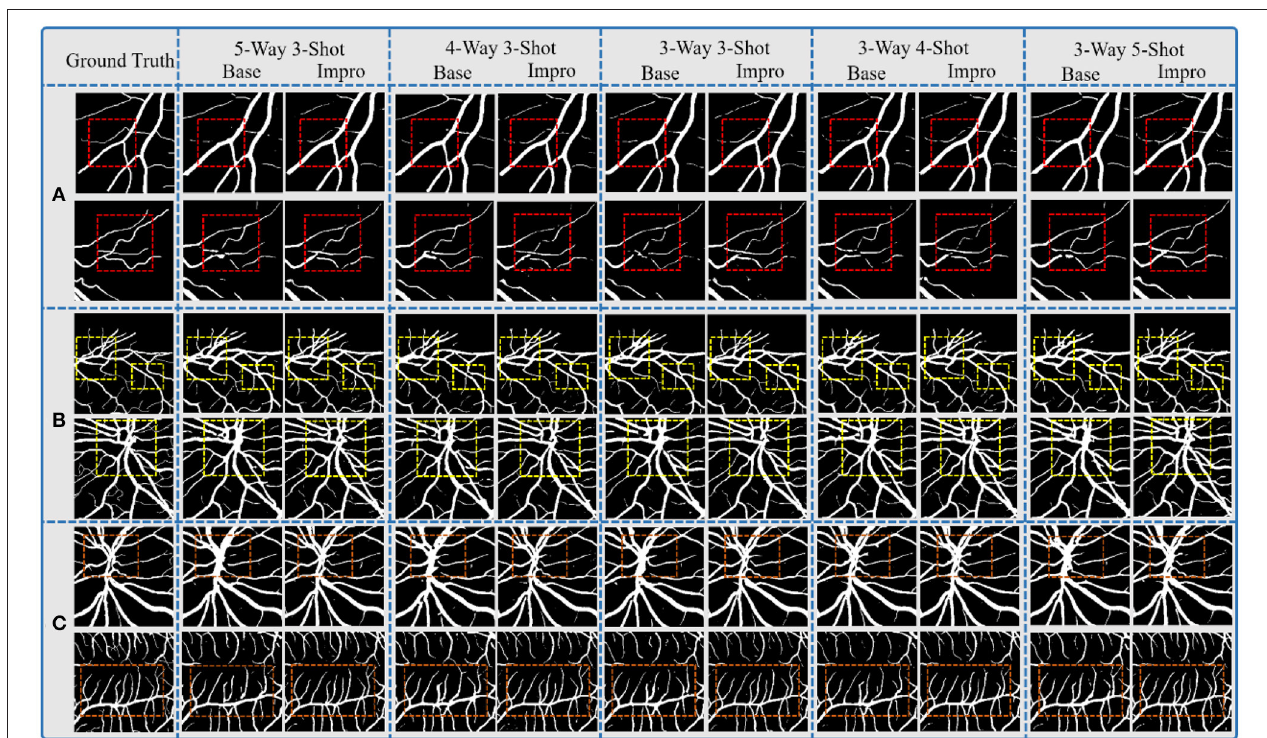
FIGURE 9 | Comparison of the baseline and upgraded models on segmentation results: (A) CHASEDB; (B) DRIVE; and (C)